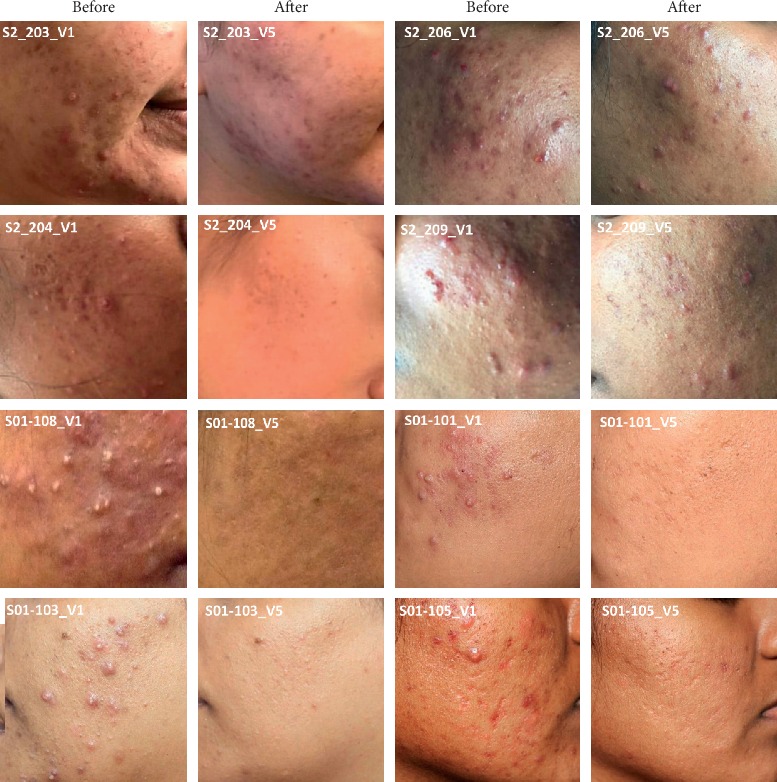
Representative skin lesion images before (week 0) and after (week 24) treatment. The different labels on the picture represent different patient ids including the site number (S1 or S2), patient number (###), and visit (V1 or V5).